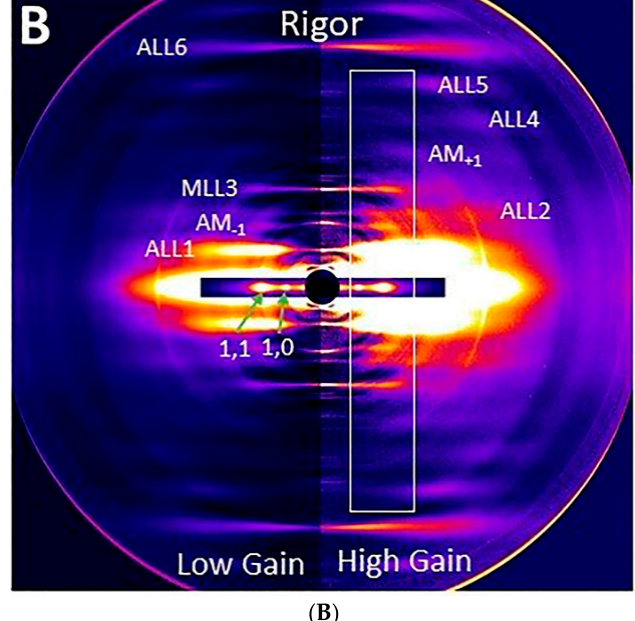
Figure 1. X-ray diffraction patterns from mouse EDL muscle. ( A ) Patterns from resting (left) and contracting (right) mouse EDL muscle. The equatorial reflections and myosin layer lines (MLL) are as indicated. ( B ) X-ray pattern from muscle in rigor at low gain (left) and at high gain (increased 3-fold, right). The equatorial reflections and actin-based layer lines (ALL) are as indicated. The box indicates the range used for the integrated intensity trace shown in Figure 2. C4: 4th myosin binding protein C reflection; M3: third order myosin meridional X ‐ ray reflection; M6: sixth order myosin meridional reflection. AM: actomyosin.